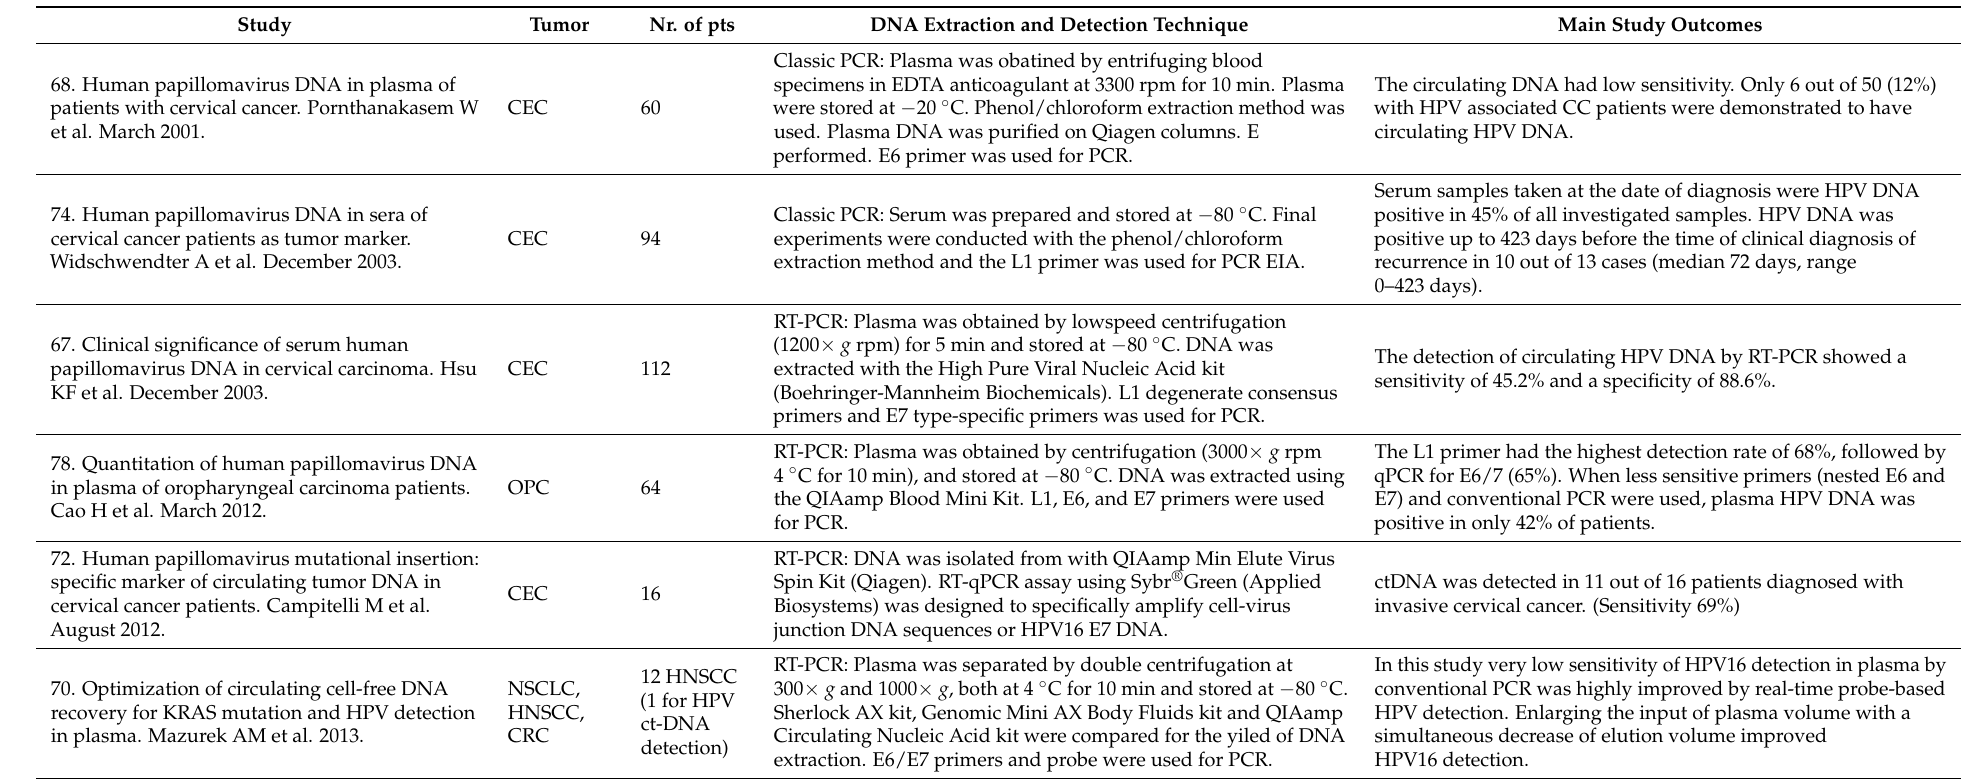
Table 1. The main studies that investigated on the techniques and clinical utility of the circulating HPV DNA detection in patients affected by HPV-positive cervical cancer (CEC) and oropharyngeal cancer (OPC). Abbreviation: CEC = Cervical cancer; OPC = Oropharyngeal cancer; HNSCC = head and neck squamous cell carcinoma; SCAC = squamocellular anal carcinoma; NSCLC = non-small cell lung carcinoma; CRC = colorectal cancer; RT-PCR = Real Time polymerase chain reaction; ddPCR = droplet digital PCR; NGS = next generation sequencing; ctDNA = circulating tumor